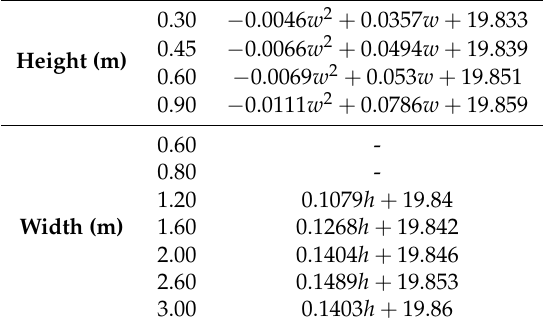
Figure A3. Comparison of surface temperatures for a 21-type radiator, h = 0.9 m. IDA ICE (crosses) vs. 4th order polynomial interpolation (diamonds). Table A1. Operative temperature t op ( ◦ C) in function of panel width and height, 10-type.